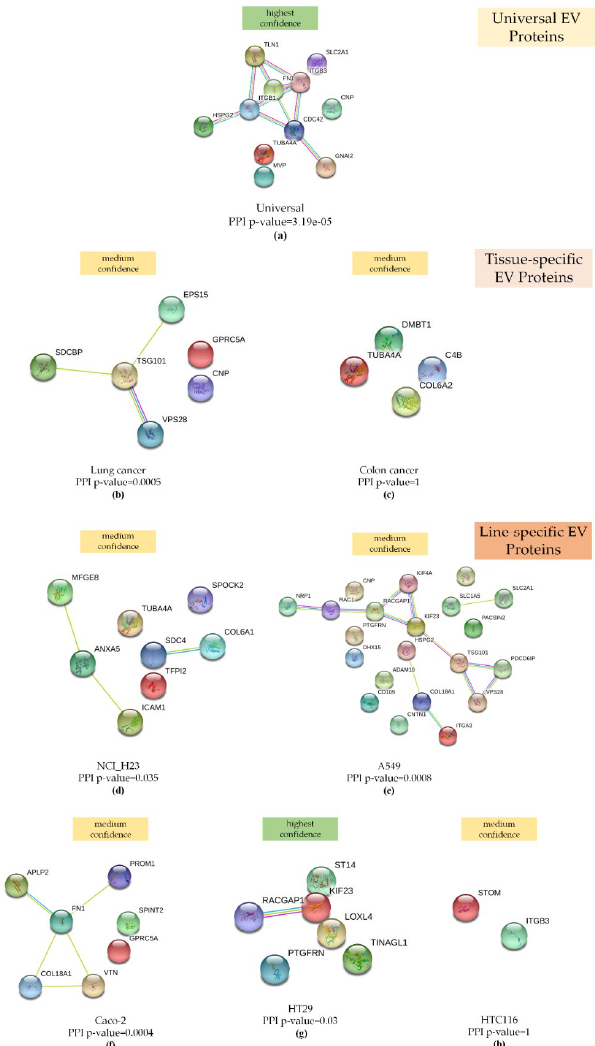
Figure 6. STRING interaction analysis ( a ) for 11 proteins that were more abundant in EVs compared to the WhL: The network was built based on the highest confidence (0.9) and enriched in interactions (PPI enrichment p -value = 3.19 × 10 −5 ); ( b ) for the 6 proteins that were specific for lung tissue-derived EVs, the network was built based on medium confidence (0.4), and the network was enriched in interactions (PPI enrichment p -value = 0.0005); ( c ) for the 4 proteins that were specific for colon tissue-derived EVs, the network was built based on medium confidence (0.4), and the network was not enriched in interactions (PPI enrichment p -value = 1); ( d ) for the 8 proteins that were specific for NCI-H23-derived EVs, the network was built based on medium confidence (0.4), and the network was enriched in interactions (PPI enrichment p -value = 0.035); ( e ) for the 21 proteins that were specific for A549 cell-derived EVs, the network was built based on medium confidence (0.4), and the network was enriched in interactions (PPI enrichment p -value = 0.0008; ( f ) for the 7 proteins that were specific for Caco-2-derived EVs, the network was built based on medium confidence (0.4), and the network was enriched in interactions (PPI enrichment p -value = 0.035); ( g ) for the 6 proteins that were specific for HT29 cell-derived EVs, the network was built based on highest confidence (0.9), and the network was enriched in interactions (PPI enrichment p -value = 0.03); ( h ) for the 2 proteins that were specific for HTC116 cell-derived EVs, the network was built based on medium confidence (0.4), and the network was not enriched in interactions (PPI enrichment p -value = 1). All networks were enriched using the intersection of 8612 genes present on all platforms as the background, along with evidence from experimental protein–protein interactions (PPI) (purple lines), text-mining (bright green lines), and curated (turquoise blue lines)